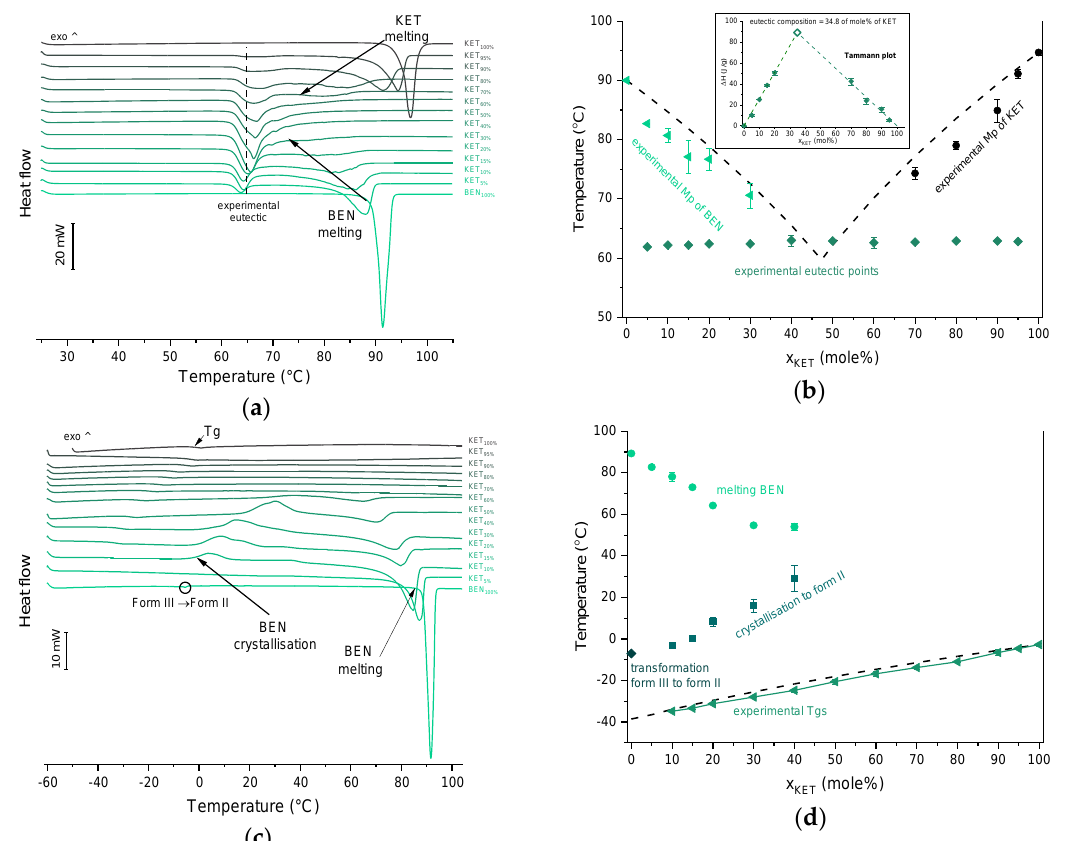
Figure 7. Thermal analysis of KET-BEN systems: ( a ) DSC thermograms from first heating; the broken line indicates the position of the eutectic peak while the arrows show the position of the melting peaks, ( b ) phase diagram based on thermal analysis of first DSC heating; the broken lines show the theoretical liquidus curves calculated using Equation (1). The Tammann plot is shown in the inset; the broken lines present the best linear fits to the experimental data, ( c ) DSC thermograms from second heating (the samples were first heated 110 °C at 10 °C/min, quench cooled at a nominal cooling rate of 300 °C/min and reheated at 10 °C/min) ( d ) phase diagram based on thermal analysis of second DSC heating; the broken line shows the theoretical Tg values calculated using Equation (2). For plots (a) and (c) the subscript indicates the content of the named component in mole%.